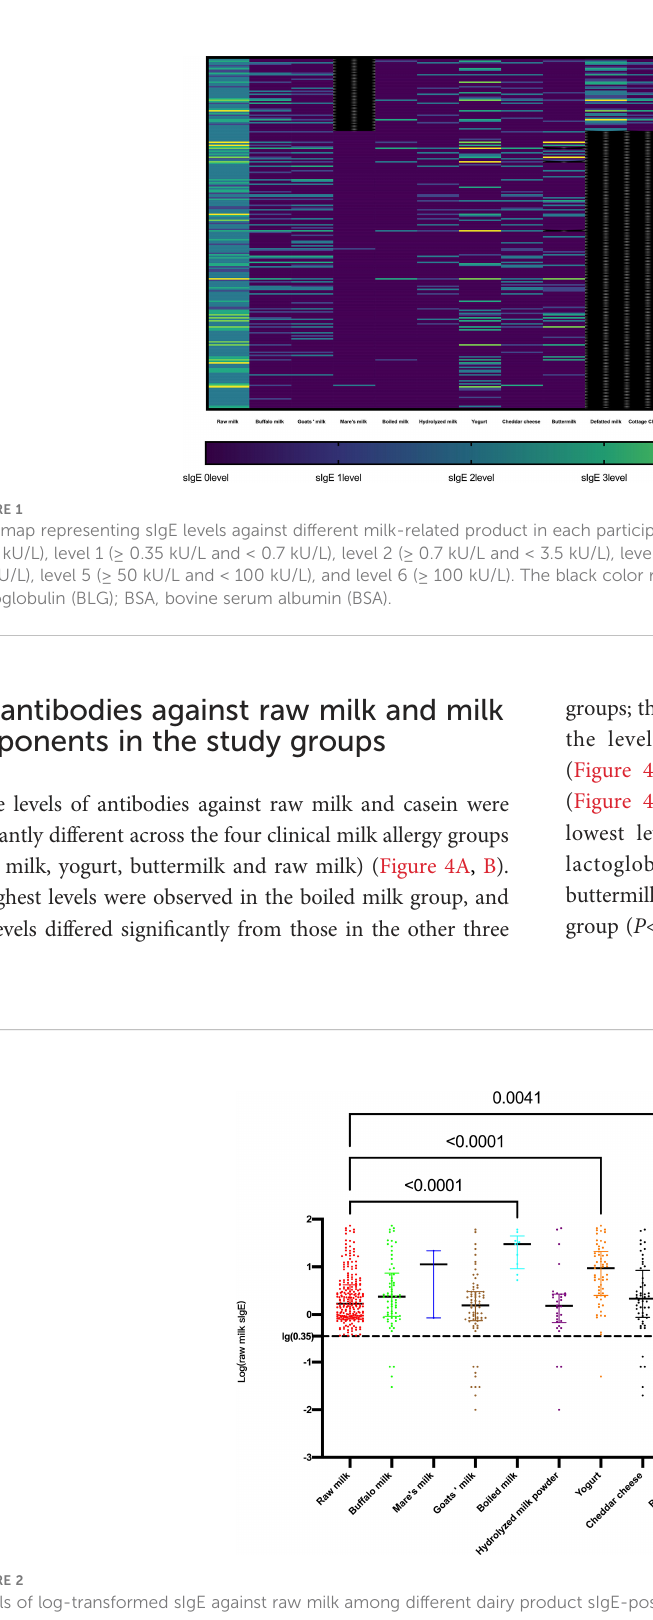
FIGURE 2 Levels of log-transformed sIgE against raw milk among different dairy product sIgE-positive